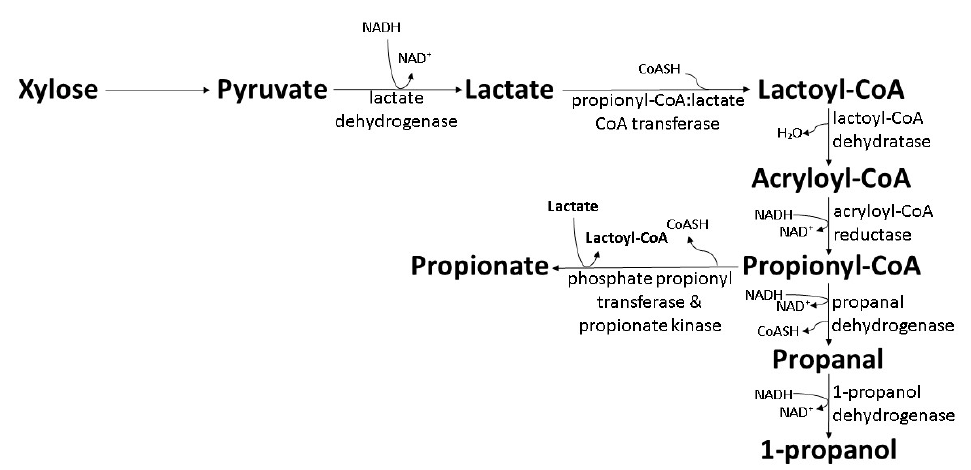
Figure 6. Biosynthesis of 1-propanol by wild-type C. propionicumable and C. neopropionicumable through the acrylate pathway [109,110].